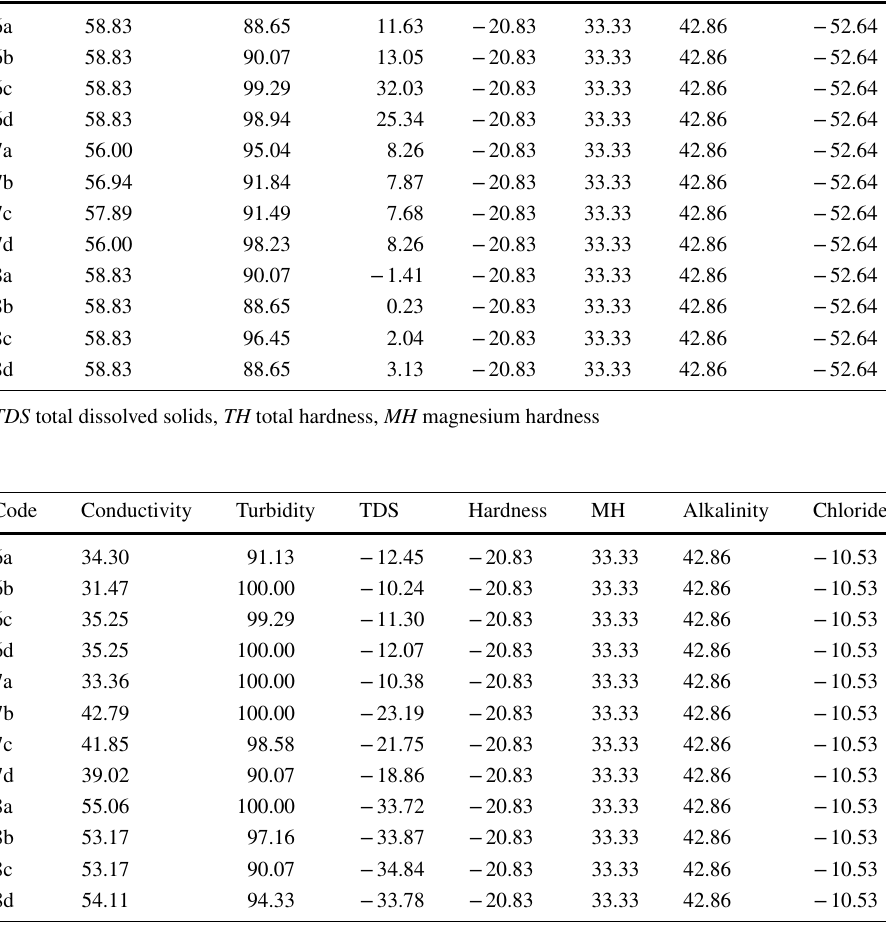
in various physicochemical parameters of surface water